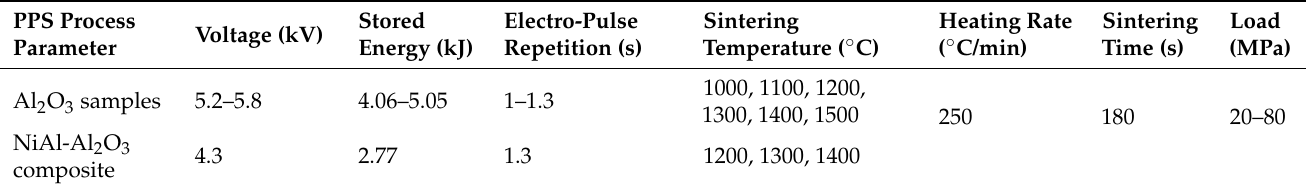
Table 1. PPS process parameters for the samples